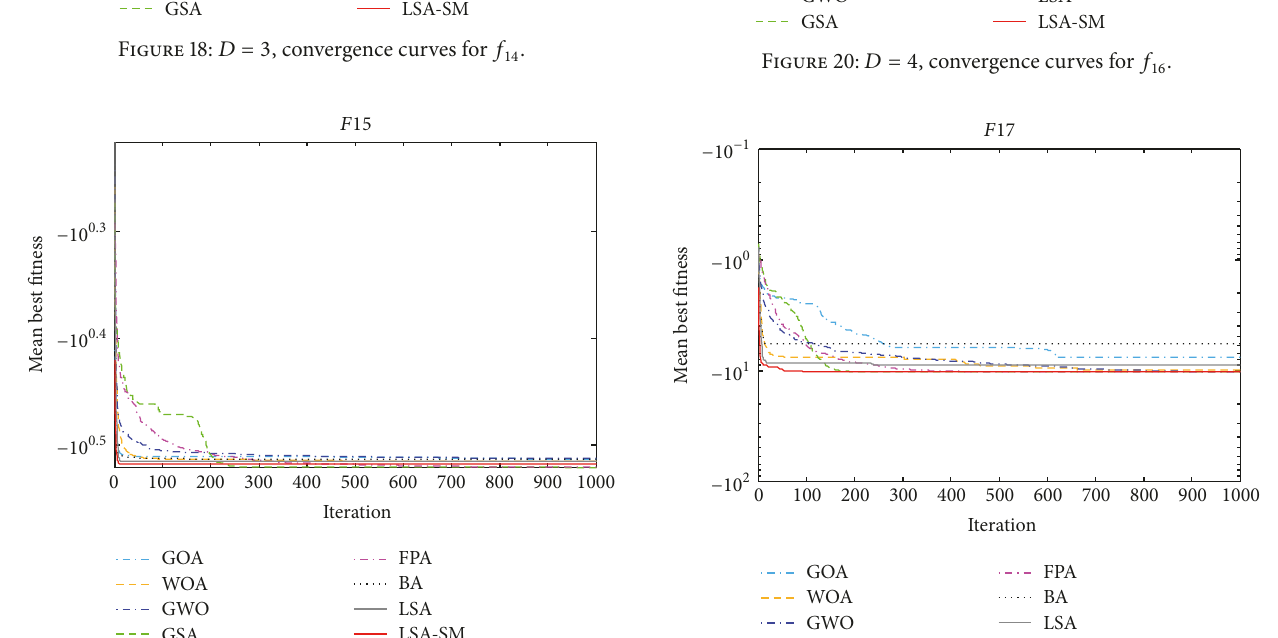
Figure 21: 𝐷 = 4 , convergence curves for 𝑓 17